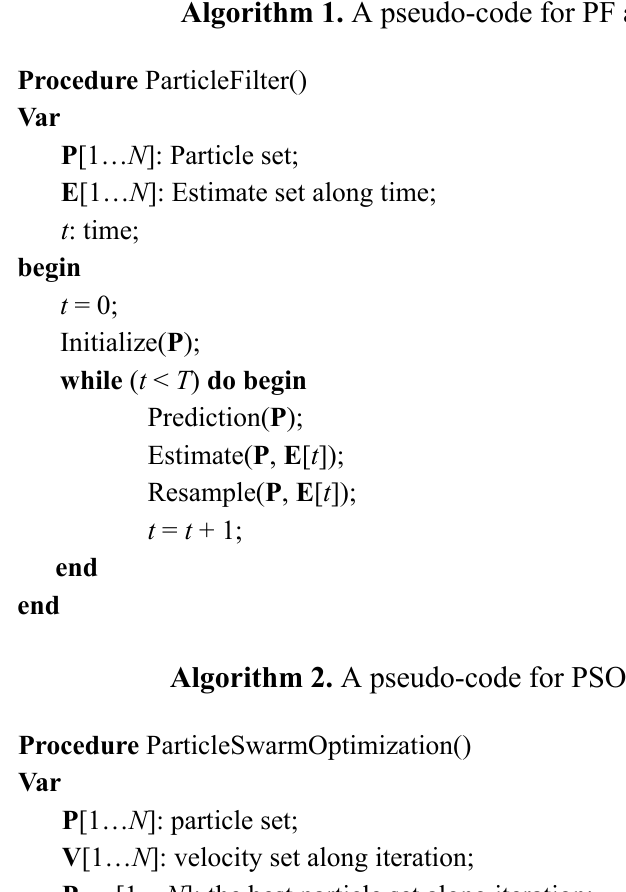
Algorithm 1. A pseudo-code for PF algorithm.